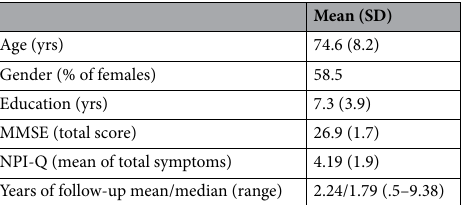
Table 1. Demographic and clinical characteristics of the study participants (n = 2137). SD standard deviation, MMSE mini-mental state examination, NPI-Q neuropsychiatric inventory questionnaire.